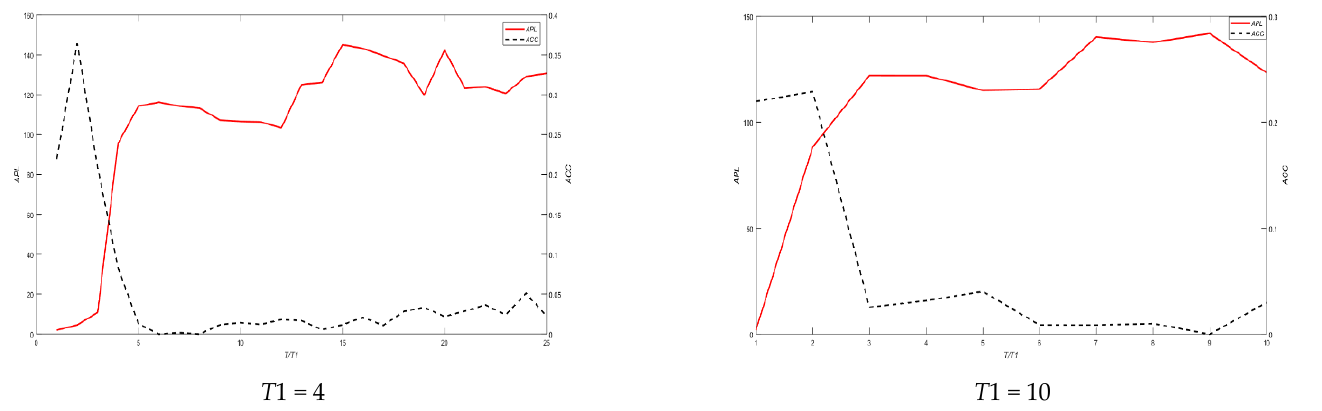
Figure 11. Effect of changes in structural evolution period T 1 on APL and ACC .